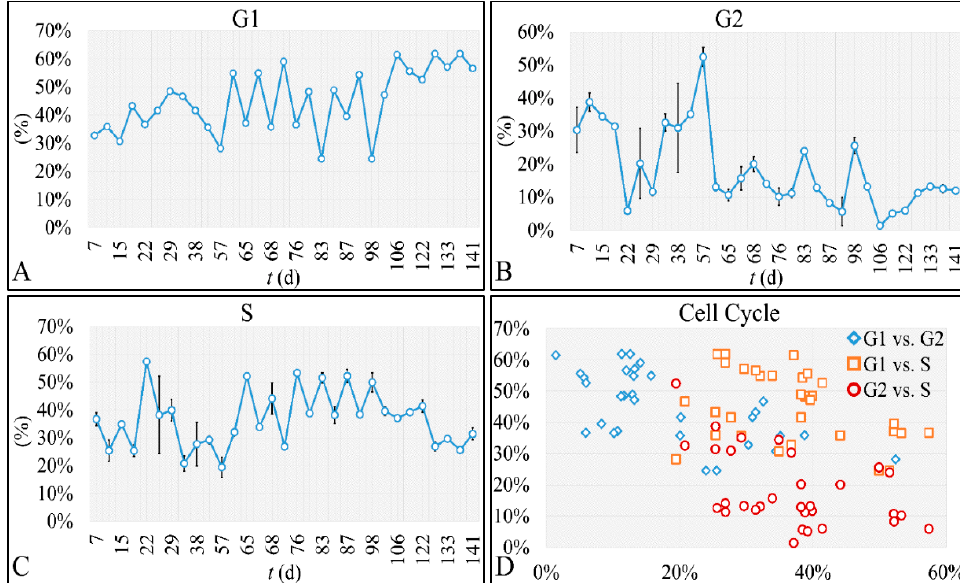
Figure 8 . The cell population’s cell cycle. The cell cycle of our cellular system manifested oscillatory patterns for G 1 ( A ), G 2 ( B ) and S-phase ( C ). In addition, a scatter plot of the three cell cycle phases in all combinations showed a discrete separation of the three cell cycle phases ( D ).